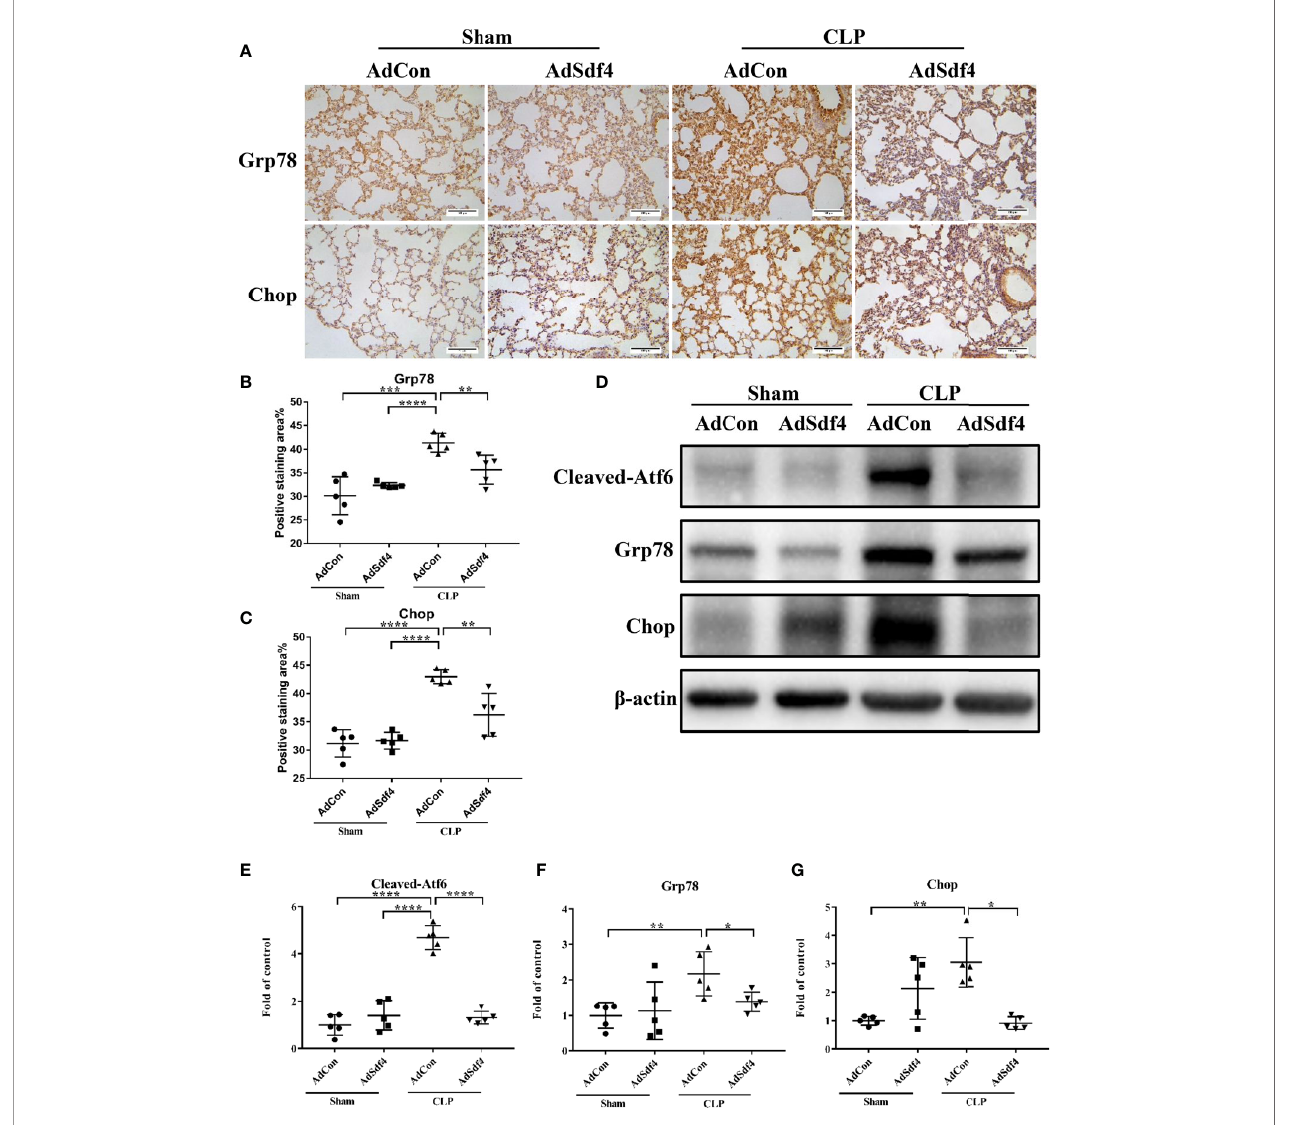
FIGURE 7 | (A) Representative photomicrographs of Grp78 and Chop from sham-operated and CLP mice lung treated with AdCon or AdSdf4 (original magni fi cation ×400). Scale bar, 100um. (B, C) Positive staining area of Grp78 and Chop from four groups. (D) Representative western blot results from four groups for levels of cleaved- Atf6 , Grp78 , Chop , and b -actin. (E – G) The cleaved- Atf6 , Grp78 and Chop bands were quanti fi ed by densitometry and normalized to the density of b -actin. n=5. Data were shown in Mean ± SD. ****p < 0.001, ***p < 0.001, **p < 0.01, *p <